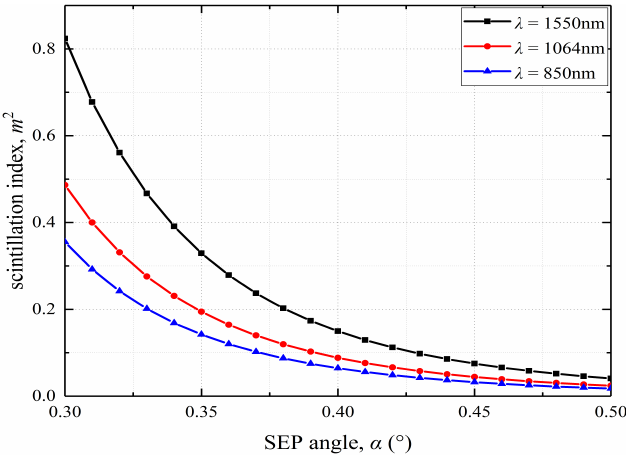
Figure 5. The scintillation index against wavelength under different SEP